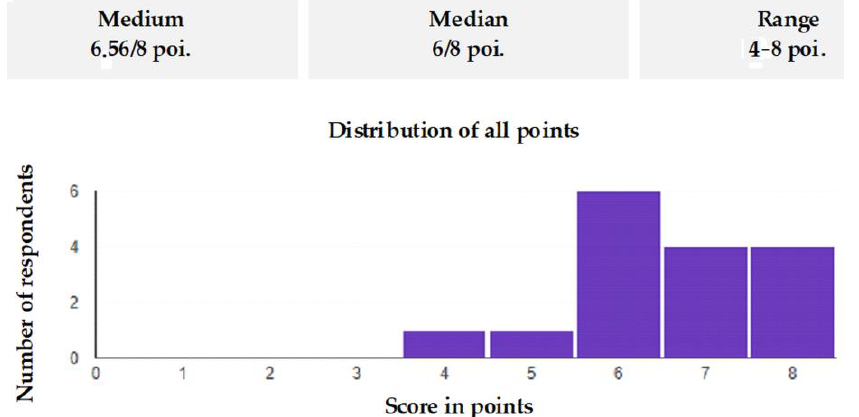
Figure 6. Summary of results from the selected training day.